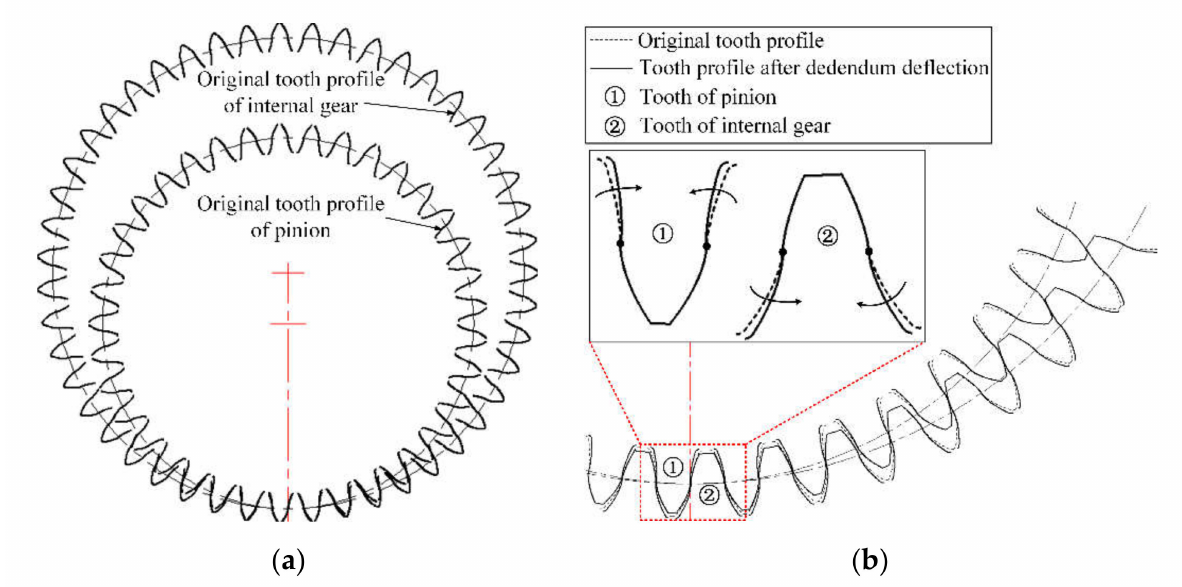
Figure 7. HCR gear tooth profile before and after root modification: ( a ) Unmodified gear profile. ( b ) Tooth root modification profile of pinion 1 (cid:13) and internal gear 2 (cid:13)